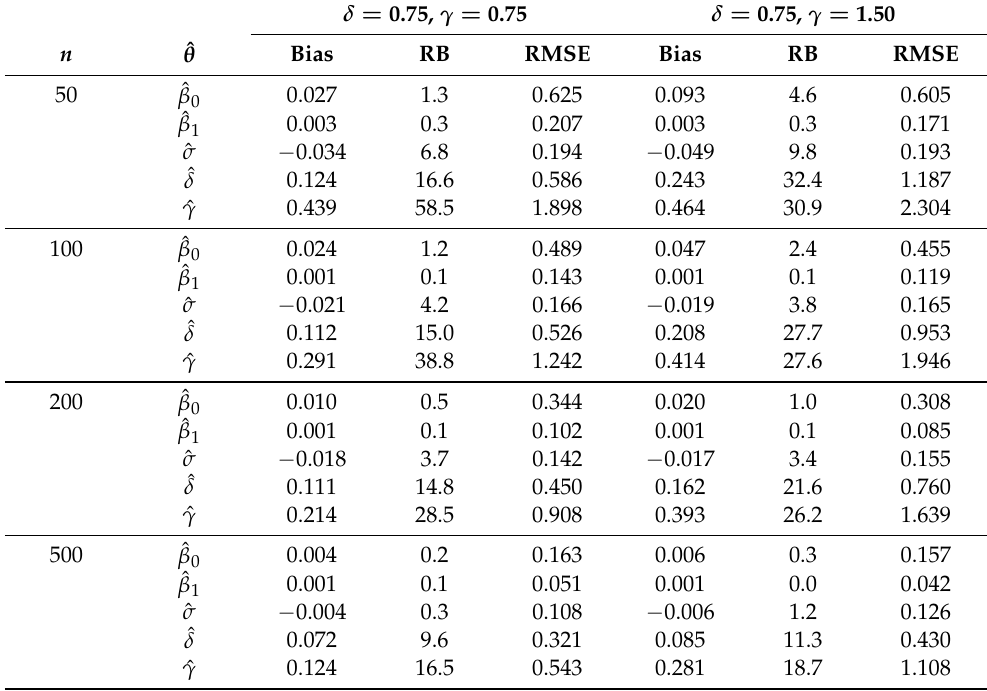
Table 1. Performance evaluation for the MLE of β 0 , β 1 , σ , δ and γ under LGN model for δ = 0.75 and γ = 0.75,1.50.